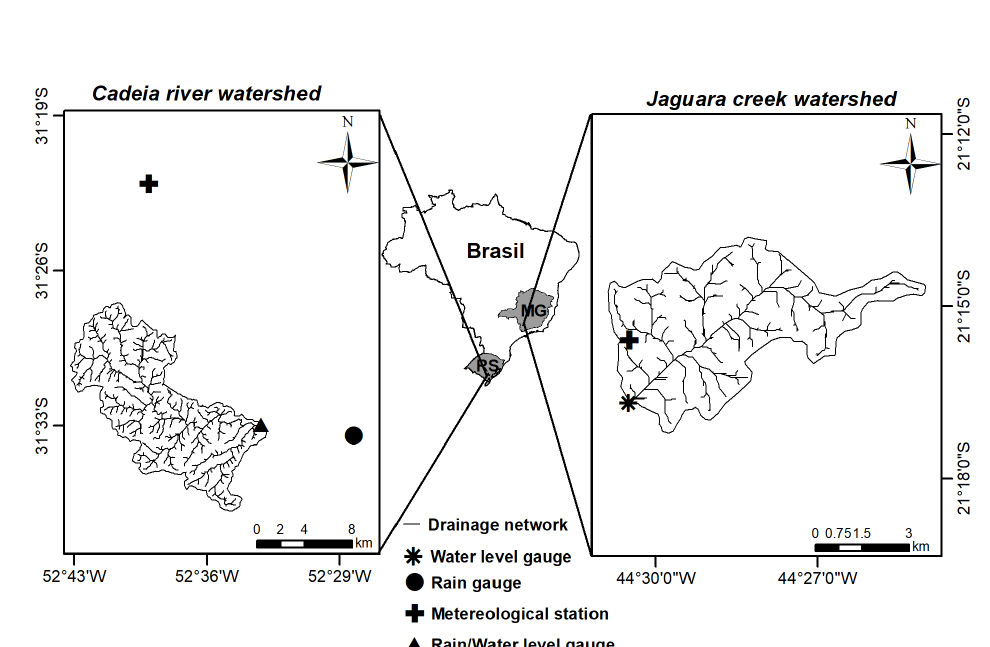
Figure 1 - Geographical location of CRW and JCW and setup of their hydrological monitoring